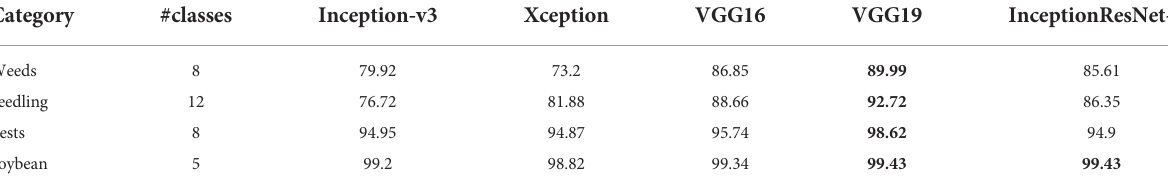
TABLE 8 Macro average test accuracies for pests and weeds category on test set. Category